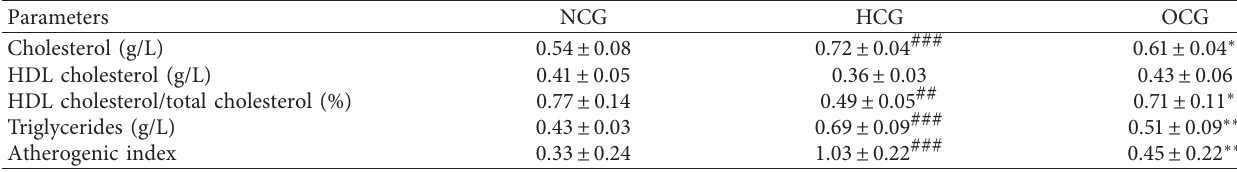
Table 3: Effect of the ODSO on the lipids parameters levels.